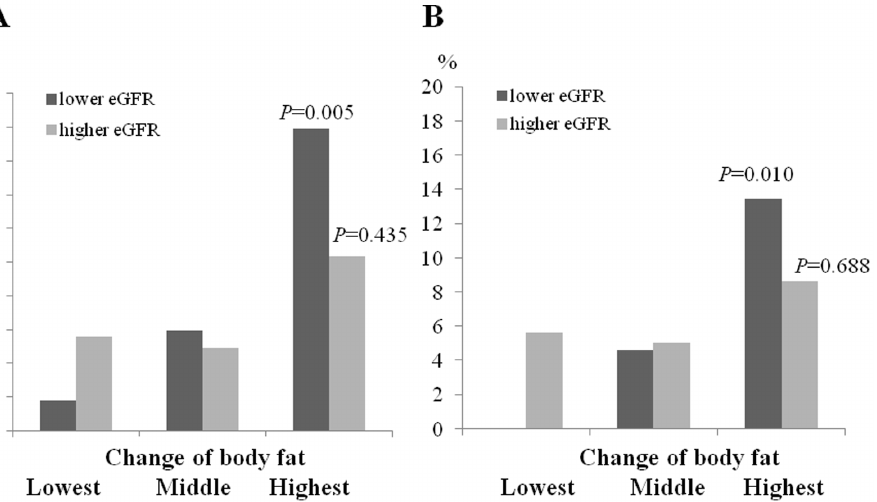
Figure 3. The incidence of renal outcome according to the changes of body fat. (A) The incidence of rapid renal according to the increase in body fat percent in participants with lower eGFR and higher eGFR . (B) The incidence of decline in eGFR . 25% according to the increase in body fat percent in participants with lower eGFR and higher eGFR.